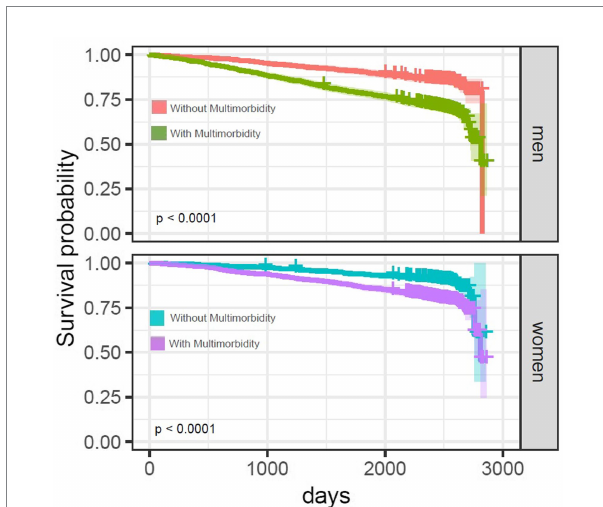
FIGURE 1 Kaplan–Meier survival curves for men and women with and without multimorbidity. Kaplan–Meier curve shows the time to death for individuals with and without MM. Censored data (vertical sign-on lines) denotes participants no longer available in KORA-Age 3 who did not experience death. There were statistically significant ( p < 0.0001) differences in survival probability between 2 groups in both men and women based on the log-rank test.